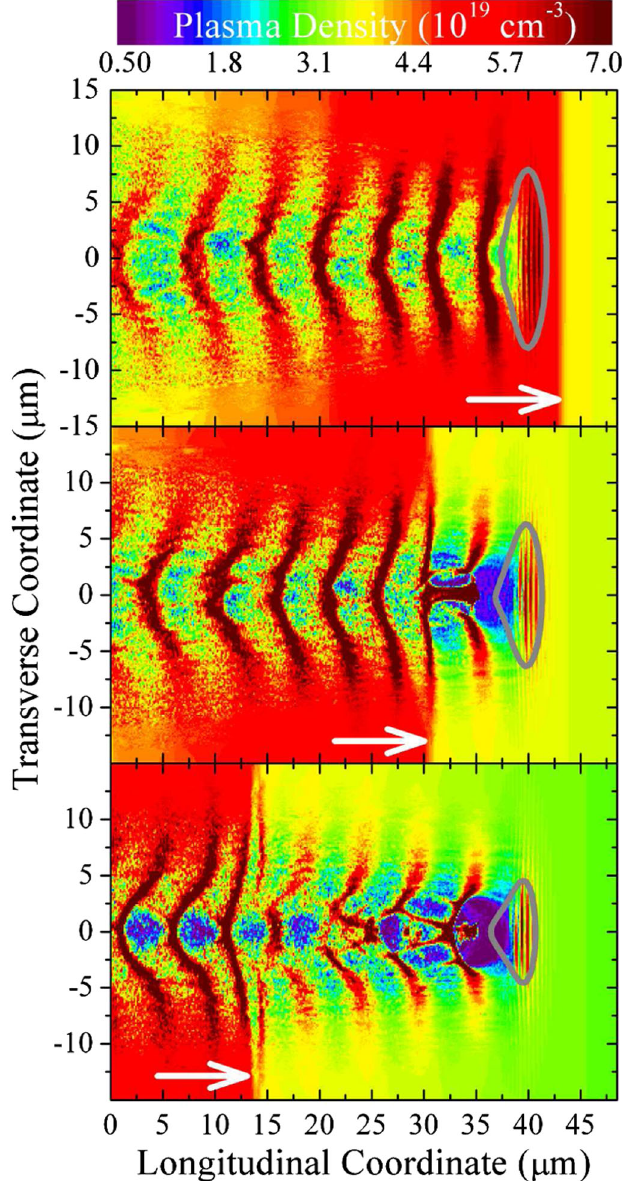
FIG. 4. State of the accelerator as obtained from PIC simula- tions shortly before (upper panel), immediately after (middle panel), and (cid:6) 85 fs after (lower panel) the laser pulse has crossed the density transition. White arrows indicate the position of the density transition; grey lines show the contour where 13.5% of maximum laser intensity is reached. The normalized instanta- neous laser intensity is shown in a rainbow color map. The upper panel shows a strongly driven plasma wave that does not break. Strong injection triggered by the shock front is evident in the middle panel. The strong electric field of the injected electron bunch destroys the remaining plasma wave thus impeding injec- tion in more than one wave-trough. This leads to a fully devel- oped bubble structure (lower panel) that accelerates the injected electrons to several 10 MeV energy. Since the bubble is fully loaded with electrons, no further injection occurs.